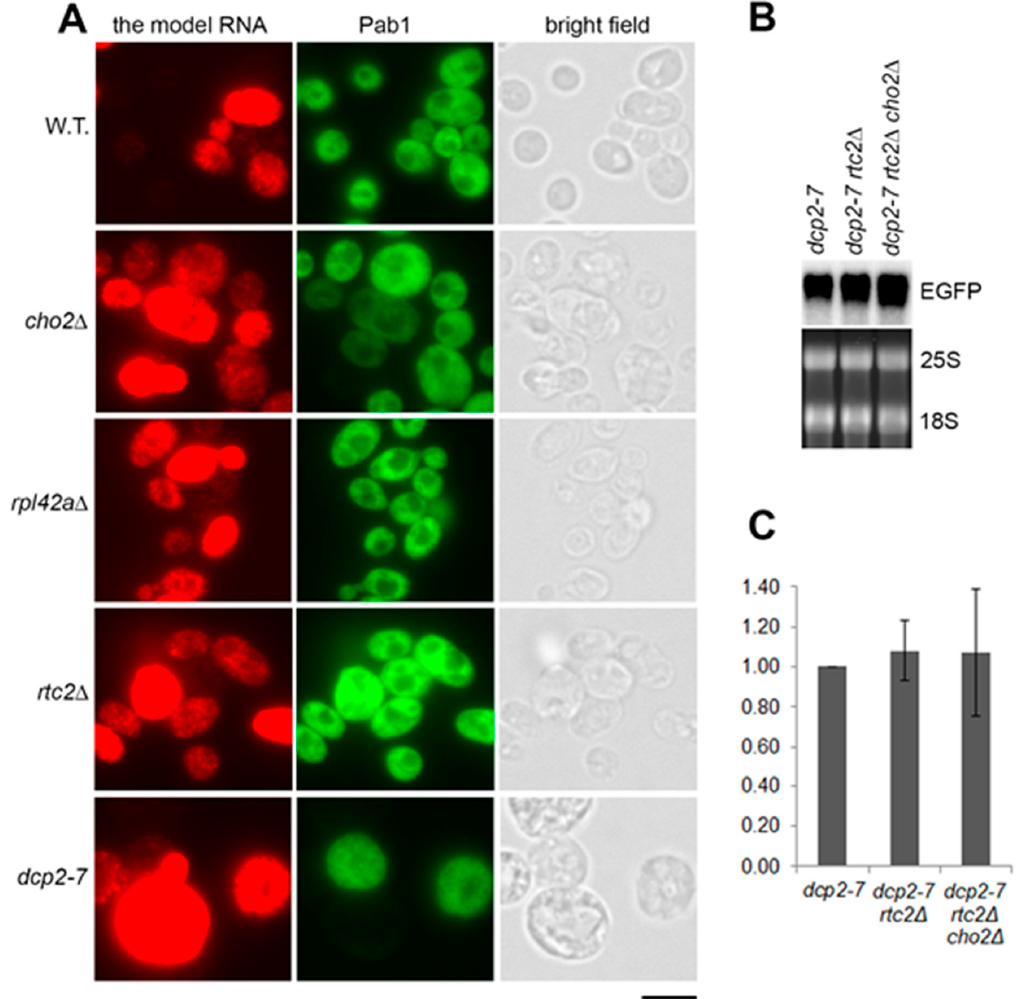
Figure 3. Accumulation of the model RNA in rtc2 Δ and cho2 Δ mutants is linked to compromised 5´ to 3´ degradation path. ( A ): The model RNA was expressed in wild-type (BY4741) and mutant strains (indicated on the left), as in Figure 2. Expression of the model RNA and Pab1 was then simultaneously detected by fluorescent in situ hybridization (FISH) and immunofluorescence, respectively (FISH-IF). Cells were examined by epifluorescence microscopy and manually counted. Scale bar is 5 µm. ( B ) and ( C ): Combining of dcp2-7 , rtc2 Δ , and cho2 Δ mutations in one strain does not lead to further accumulation of the model RNA. The model RNA was expressed as above in single, double, and triple mutants (indicated above each line) and its steady-state levels were detected by Northern blot ( B ), quantified using phosphoimager and expressed as fold increase relative to the levels in dcp2-7 mutant ( C ). Ribosomal RNA (25S and 18S) was visualized by ethidium bromide staining and served as endogenous control. Quantitation in ( C ) represents data from three experiments.